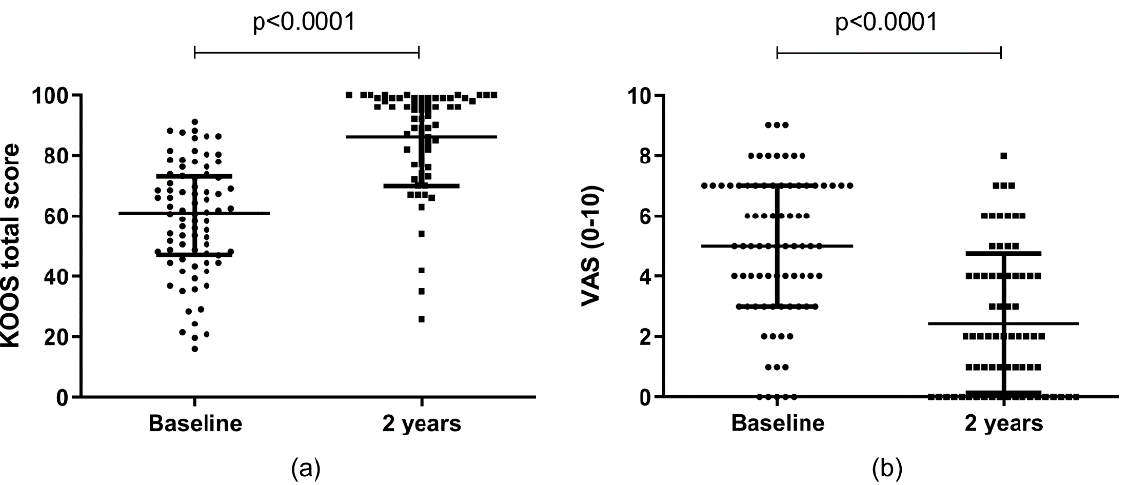
Figure 5. Comparison between KOOS total score ( a ) and VAS ( b ) at the baseline and 2 years after surgery. Data are reported as median and interquartile range.